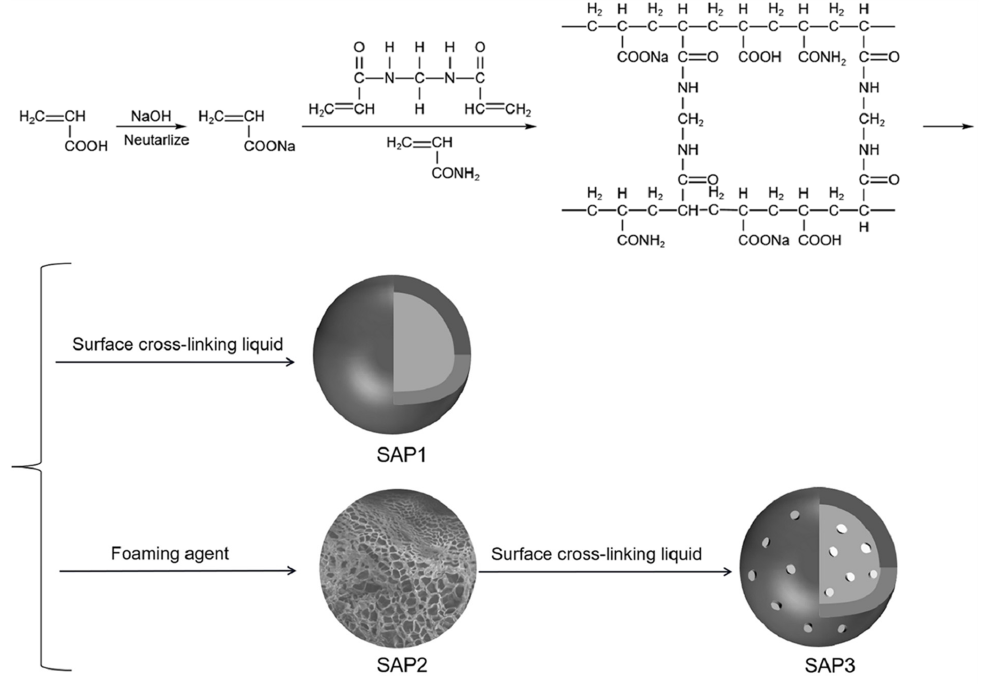
Figure 1. Preparation processes of SAP0, SAP1, SAP2, and SAP3.